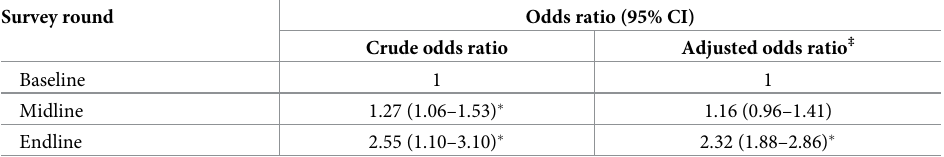
Table 5. Association between iCCM program implementation and changes in care-seeking for common childhood illness from health posts in Assosa zone, Ethiopia,